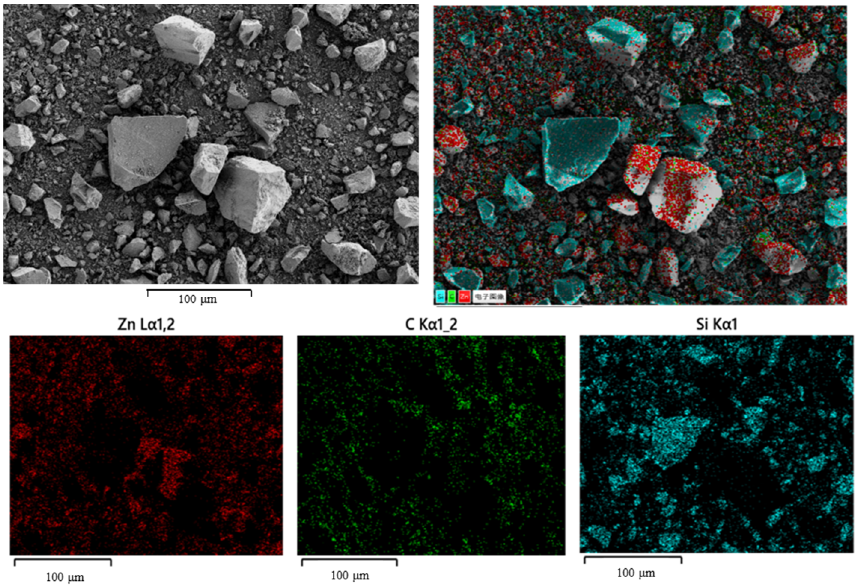
Figure 15. SEM-EDS pictures of flotation concentrate of the mixed mineral of smithsonite-quartz.